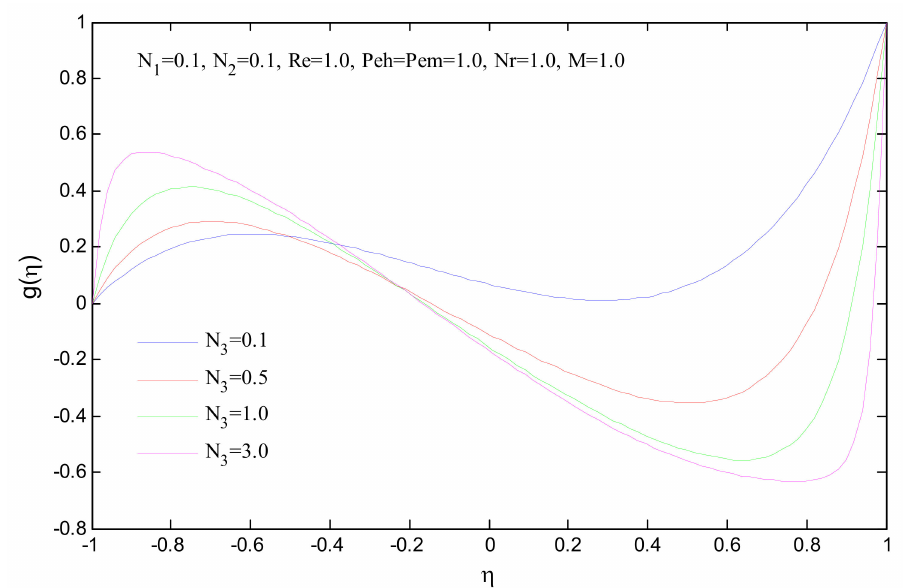
Figure 9. Effect of N 3 on microrotation